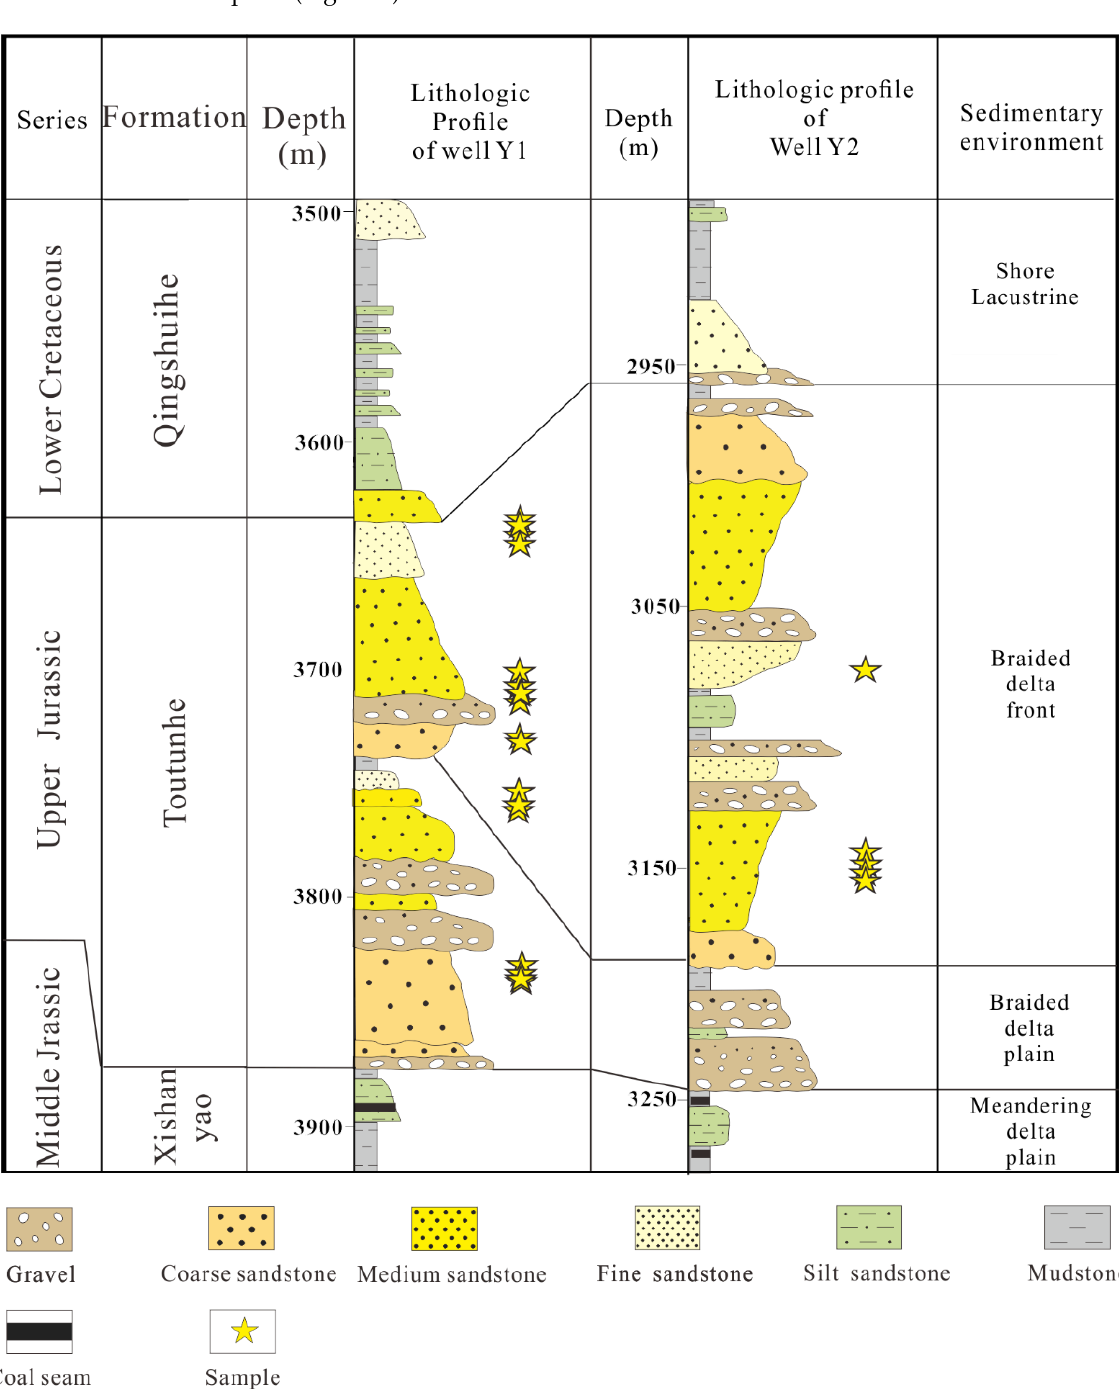
Figure 2. Lithologic profiles and sampling locations of well Y1 and well Y2 drilled in Sikeshu Sag.